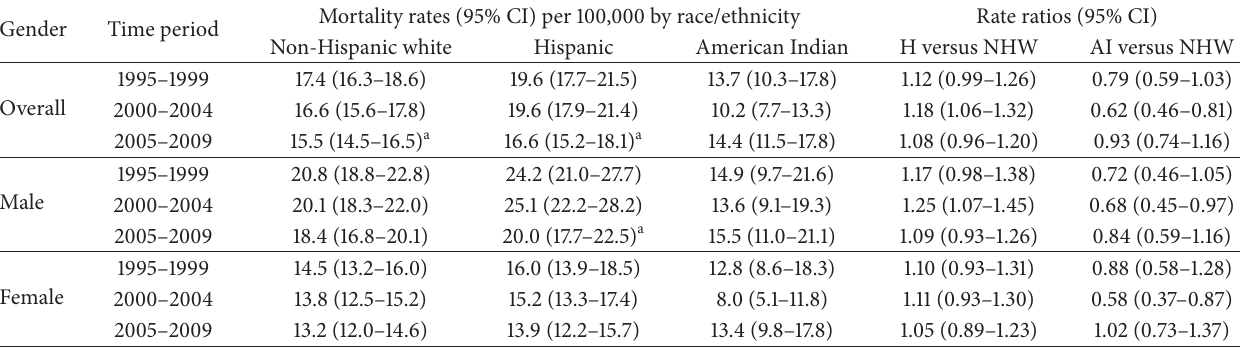
Table 4: Average age-adjusted colorectal cancer mortality rates by gender, time period, and race/ethnicity; New Mexico, 1995 to 2009.